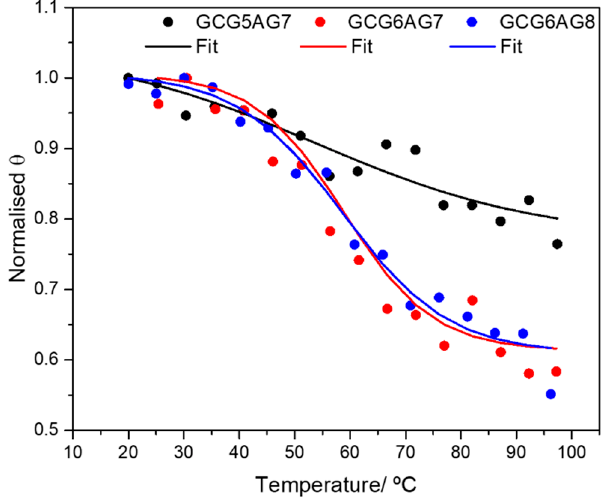
Figure 3. CD melting data: normalized value of the ellipticity Θ at the maximum of the CD spectra as a function of temperature and Boltzmann fits to the experimental data for DNA sequences GCG5AG7 (black dots), GCG6AG7 (red triangles) and GCG6AG8 (blue squares) in a phosphate-buffered solution with 30 mM of K + . The corresponding fitted melting temperatures are given in Table 1.